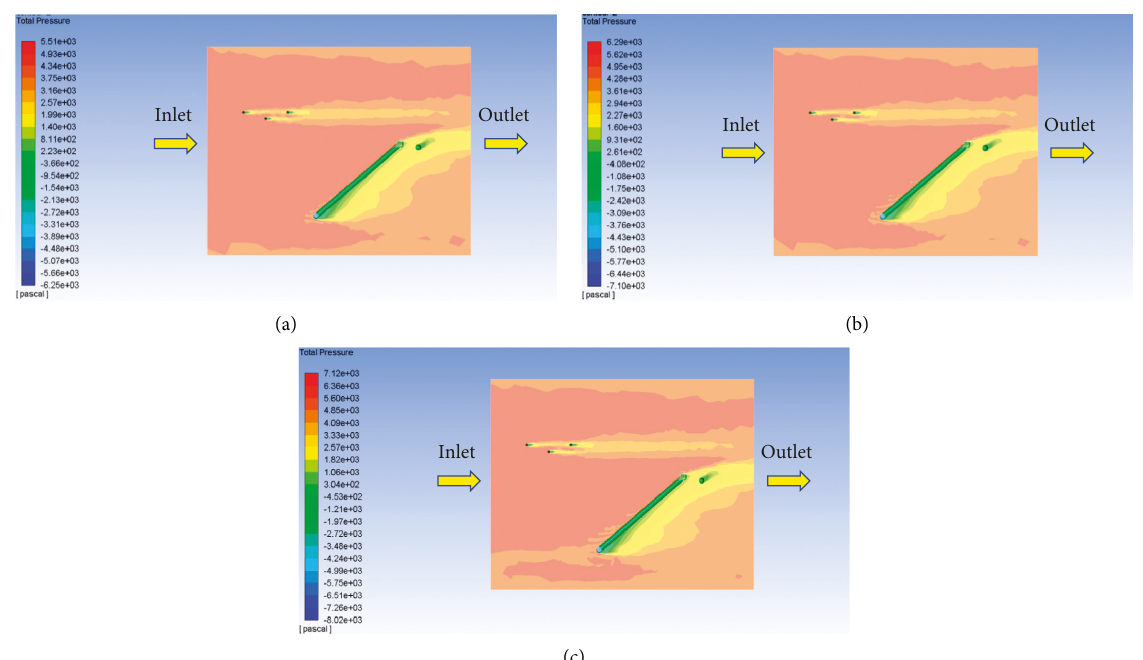
Figure 12: Pressure contours around the tested pantograph model in the symmetry plan at train speeds of (a) 300km/h, (b) 320km/h, and (c) 340km/h.